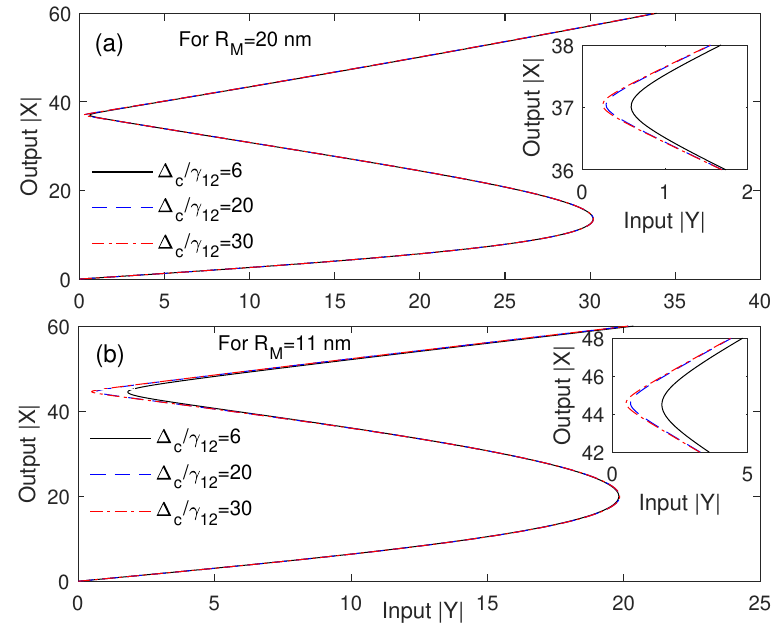
Figure 3. Output versus input for different values of the detuning of the control field at two values of the MNP radius; ( a ): R M = 20nm and ( b ): R M = 11nm. The other parameters are